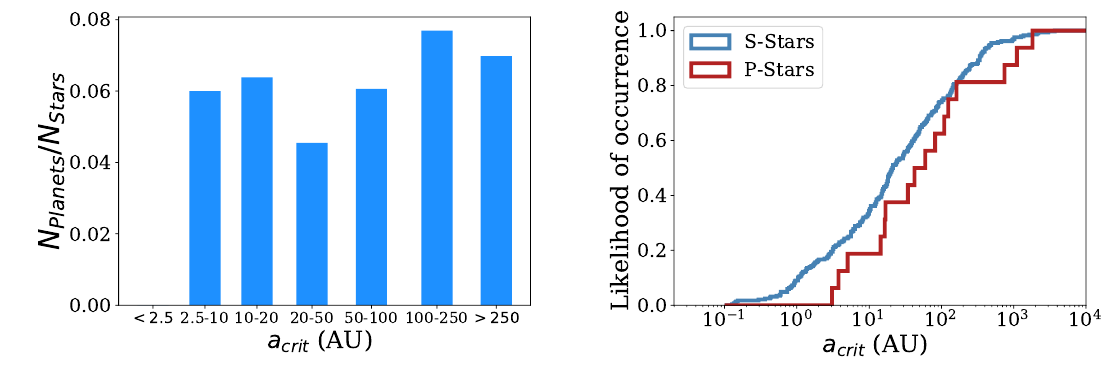
Figure 5. Left: Fraction of planet-host binaries as a function of a crit . Right: Cumulative distribution of the a crit for UD pairs with (red) and without (blue) planetary companions.